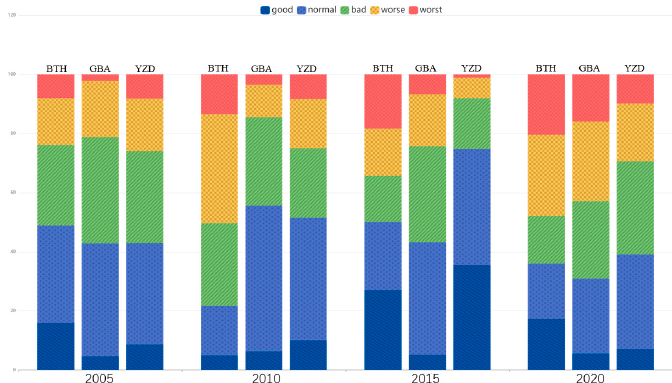
Figure 6. Proportion of UTCI in different urban agglomerations during 2005–2020.